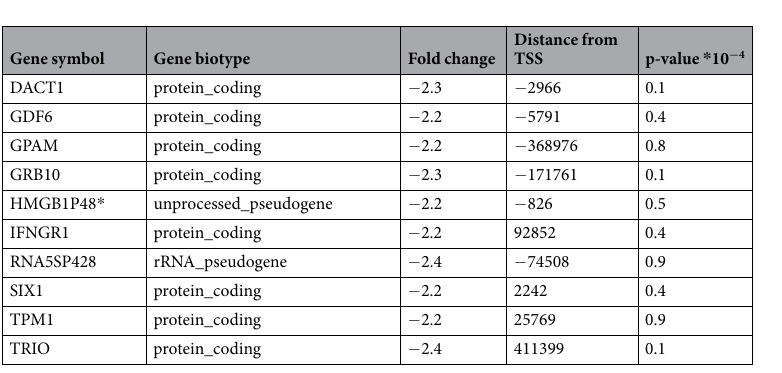
Table 1. List of the top 10 genes showing decrease in H3K9 acetylation after DAC treatment. * Indicates acetylation decrease within 2000 bp upstream the TSS.